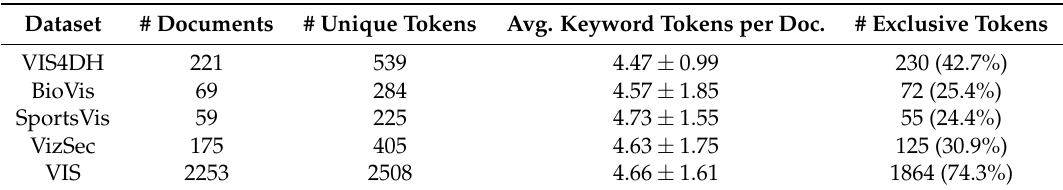
Table 1. Number of documents and keyword tokens per collection after processing. Among the four domain-specific collections, VIS4DH held the largest number of unique tokens (different tokens in a collection) and also had the highest ratio of exclusive (not found in any other collection) vs. unique tokens. In total, 659 different tokens could be found in two or more collections.